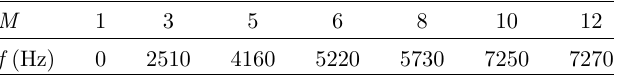
Table 1. Number of propagating modes in the connecting duct (the last line indicates the cut-off